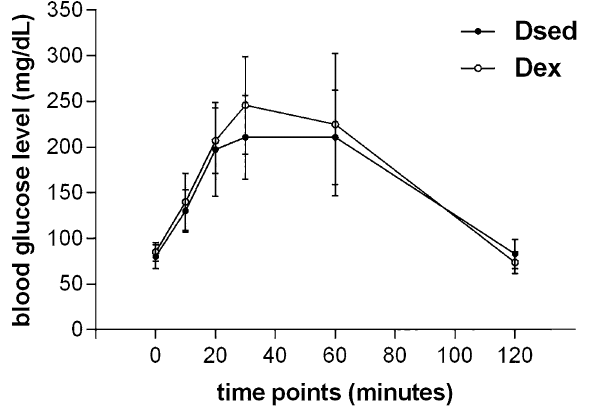
Figure 1. Oral glucose tolerance test. Blood glucose level before the test and 10, 20, 30, 60 and 120 min after the administration of intragastric glucose solution in Dsed and Dex